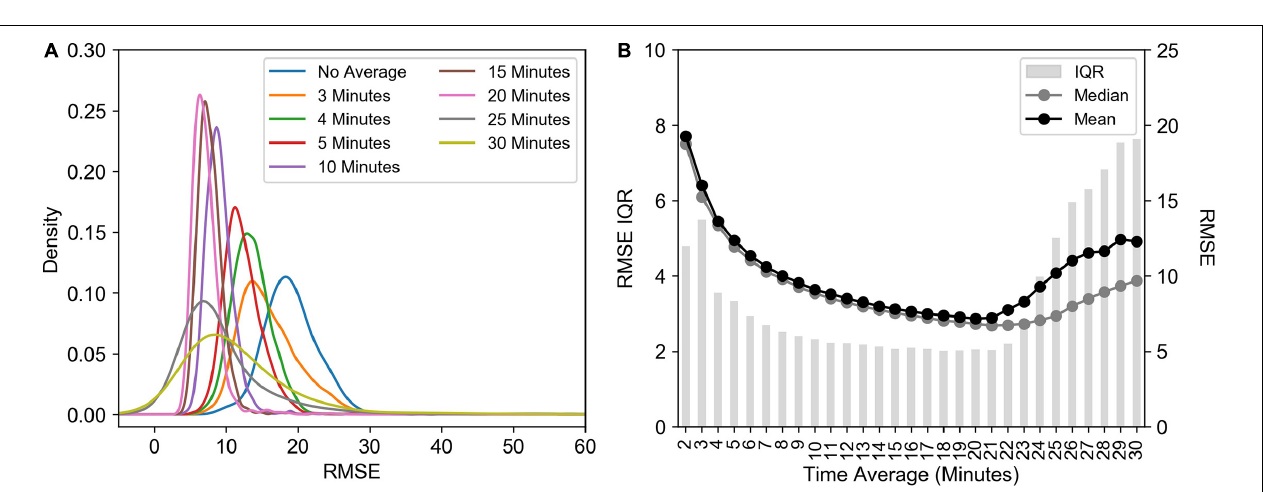
FIGURE 9 | Kernel Density Estimation of FIRe saturation bias corrected (PPU BC) and uncorrected (PPU NBC) including RMSE (A) , F v /F m (B) , and σ PSII ( (C) , calculated using the calculate ρ saturation model. The F v /F m and σ PSII results from FIRePro are also included in panels b and c. Data is from the Southern Ocean (FIRe, ACE).